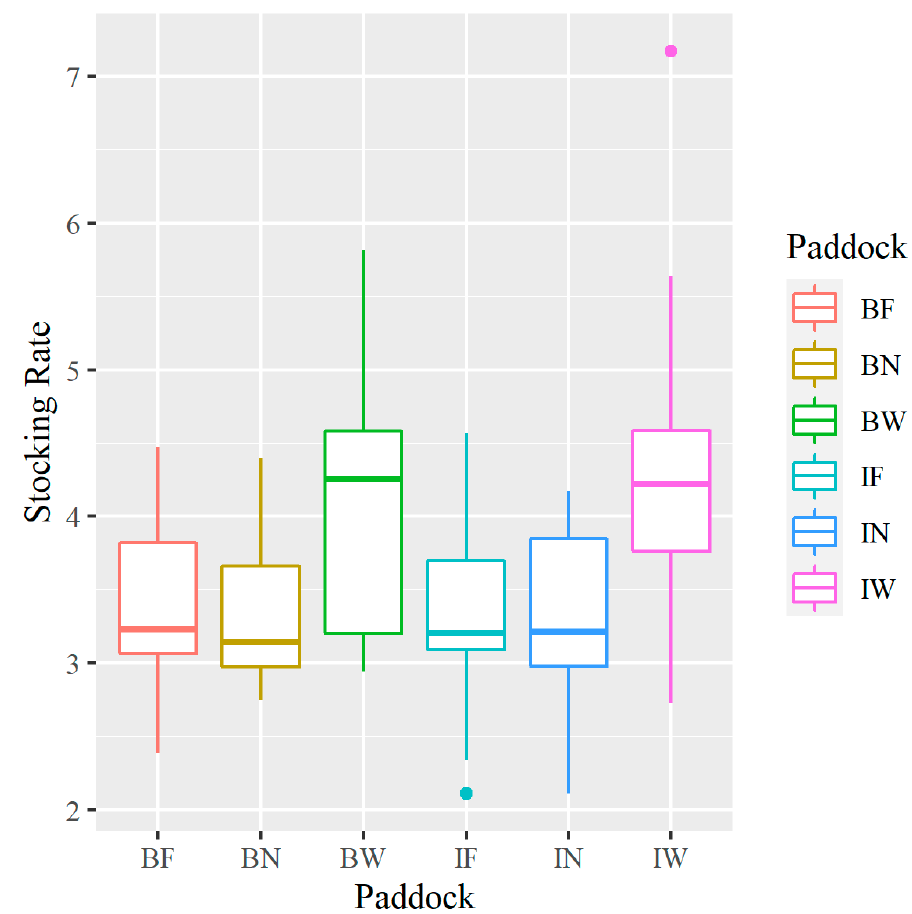
Figure 3. Box plot of stocking rates (animal number/day/ha) between paddock types. B: Broiler litter; I: Inorganic fertilizer; F: Endophyte-free; N: novel endophyte; W: Wild endophyte.